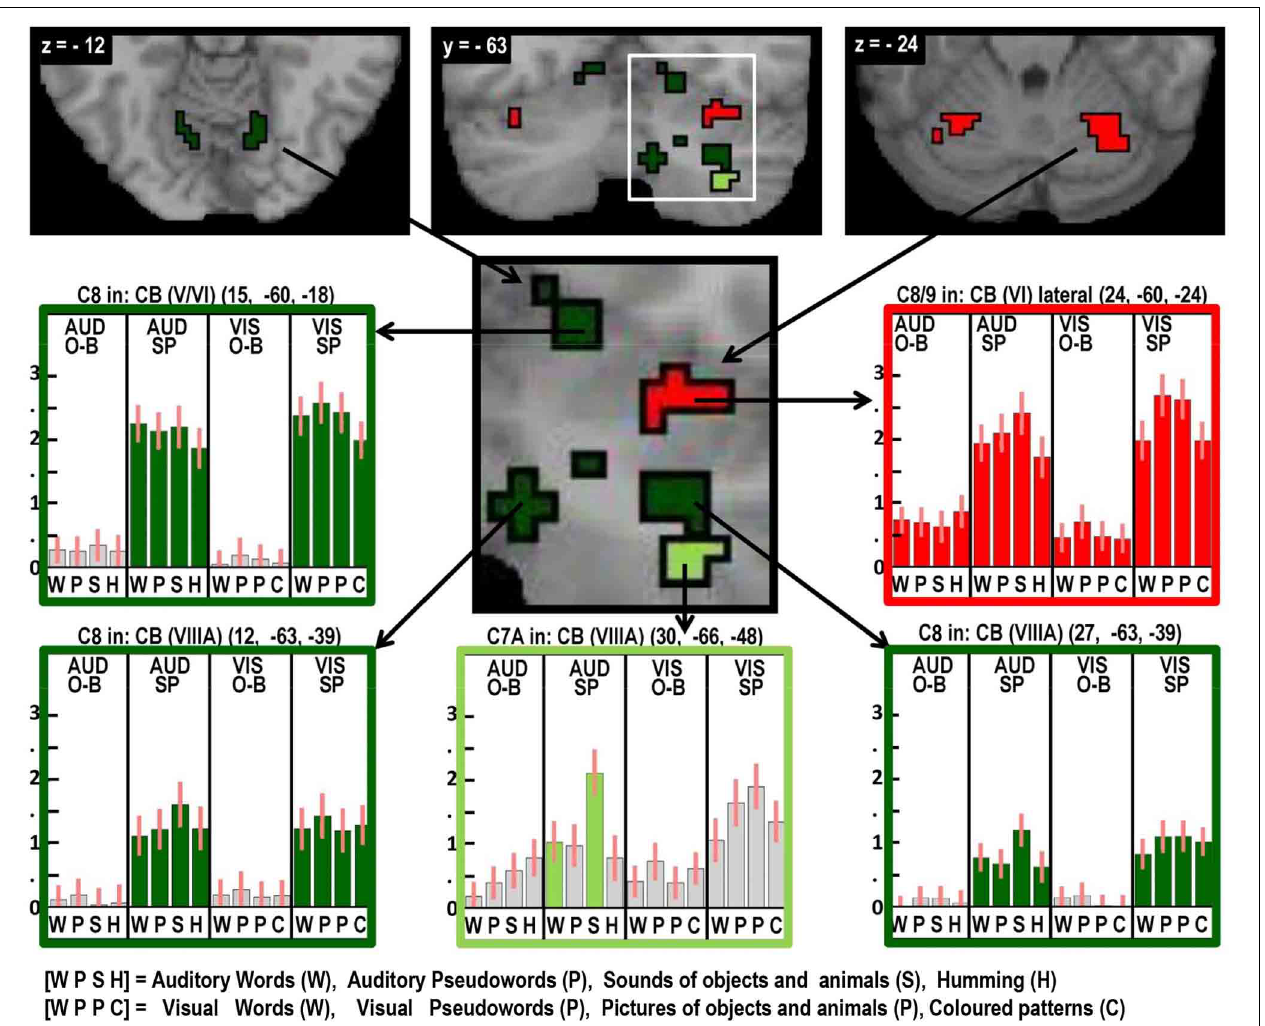
FIGURE 6 | As in Figures 2–5, highlighting many different auditory repetition effects in the